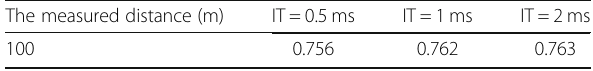
Table 4 Measured atmospheric transmittance at a distance of 100m The measured distance (m) IT = 0.5 ms IT = 1 ms